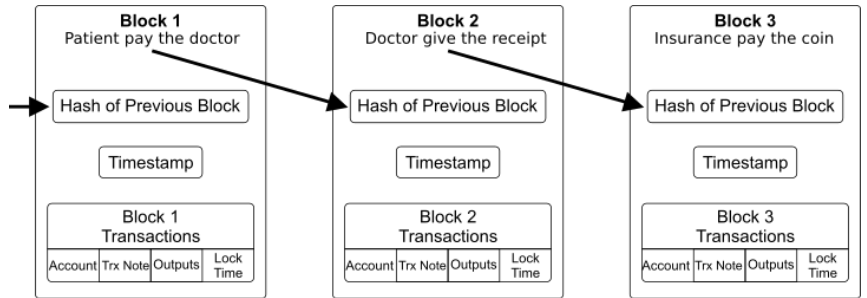
Figure 4. Patient’s block representation and encryption